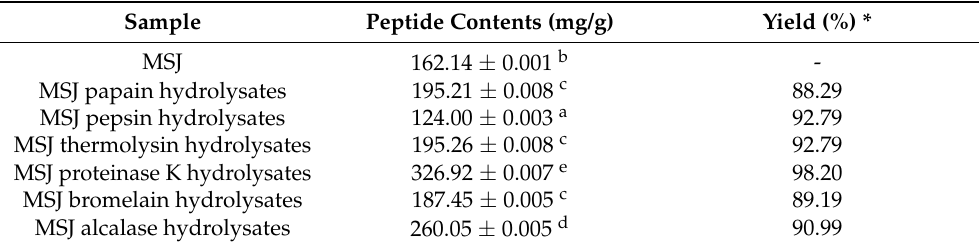
Table 5. Peptide contents and yield of mackerel steaming juice (MSJ)